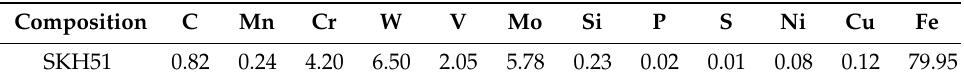
Table 2. Composition of high speed steel.